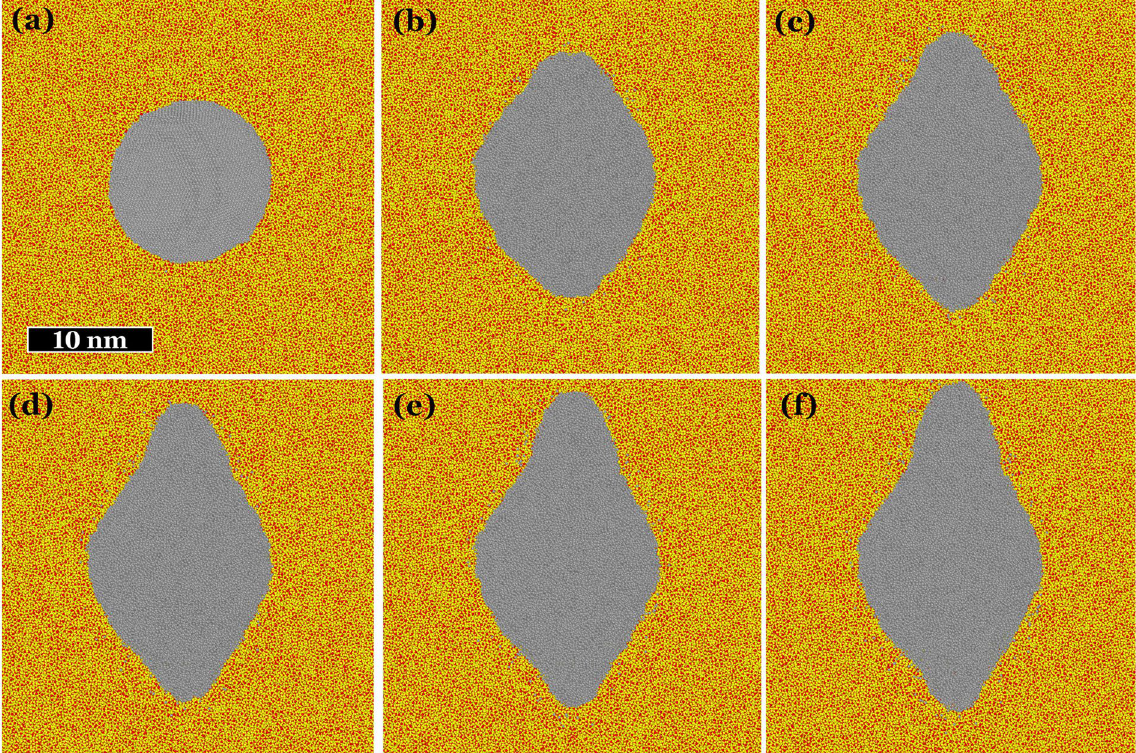
Figure 4. Evolution of silver nanoparticles embedded in silica 100 ps after energy deposition in a hot cylinder of radius a = 3.5 nm oriented with its axis in the vertical direction. Simulations were performed for an electronic stopping power of 8 keV/nm. Each image shows a thin central slide of the box used for MD simulations, ( a ) prior to irradiation and after ( b ) 2, ( c ) 4, ( d ) 6, ( e ) 8 and ( f ) 10 ion